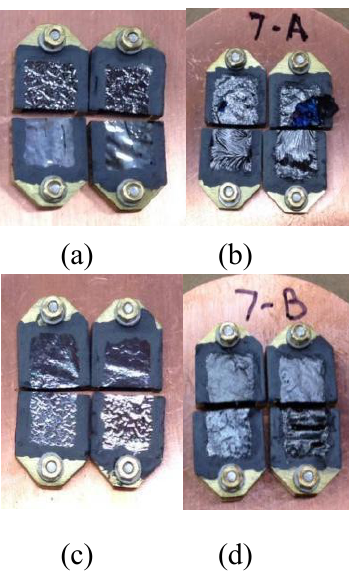
Fig. 2. Foils before and after irradiation. (a) (from left to right, up to bottom) 9 layers HBC, 7 layers HBC, DLC type1, DLC type3 foils before irradiation; (b) 9 layers HBC, 7 layers HBC, DLC type1, DLC type3 foils after irradiation; (c) (from left to right, up to bottom) 17 layers HBC, 48 layers HBC, 100 layers HBC, B+C mixture foils before irradiation; (d) 17 layers HBC, 48 layers HBC, 100 layers HBC, B+C mixture foils after irradiation.